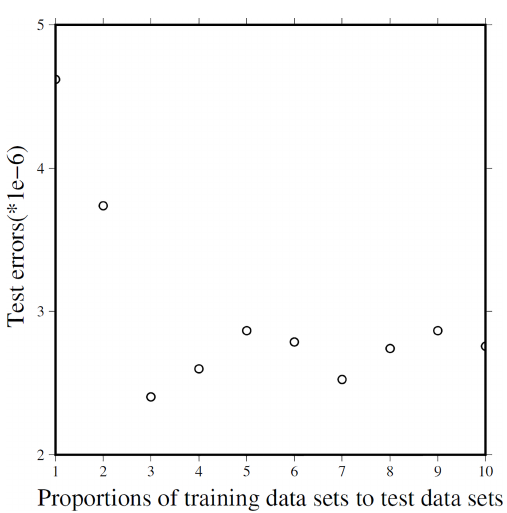
Figure 5. The relationship between proportions of training data sets to test data sets and test errors.